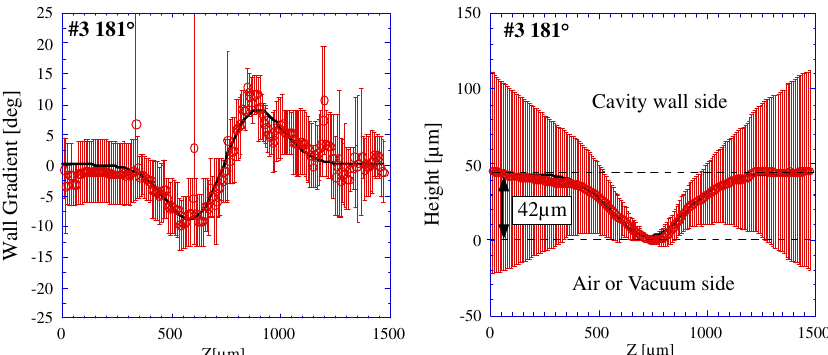
FIG. 12. (Color) Gradient and height of the spot shown in Fig. 8. The spot is convex. The height is expressed by a relative value of the distance from the cavity axis.